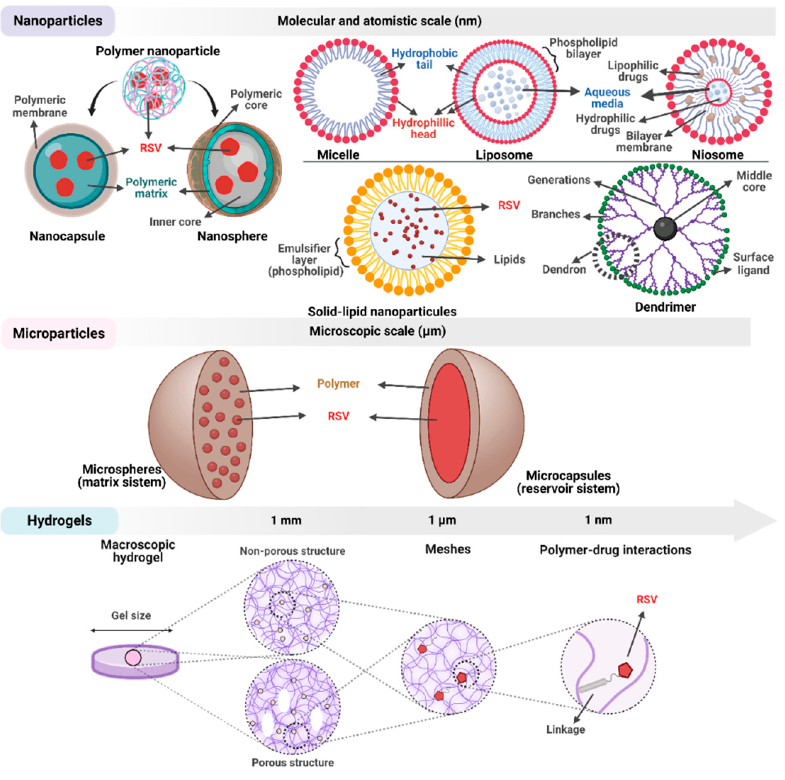
Figure 6. Structural aspects regarding the main resveratrol delivery systems successfully used to